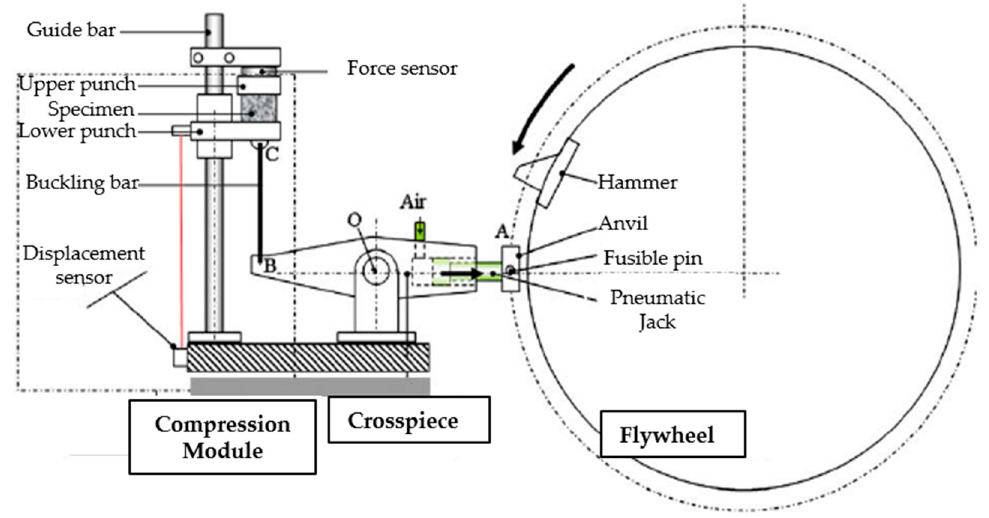
Figure 6. Scheme of compression module on flywheel (the figure is reproduced from [66], with permission from the Elsevier, 2009).